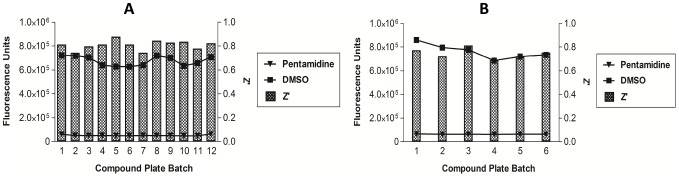
Signal and reproducibility of negative and positive controls in the T.b. brucei primary and retest assays.The negative and positive control assay signals (fluorescence intensity, left Y-axis) taken from whole control plates (one per 20 test compound plates) in the primary screening (A) and retest (B) screening campaigns. Negative controls were averaged from wells containing 0.42% DMSO and positive controls were from wells containing 2 µM pentamidine. The bar plots show the Z'-factor (Z', right Y-axis) for each control plate, a measure of the reproducibility of the controls in the assay.